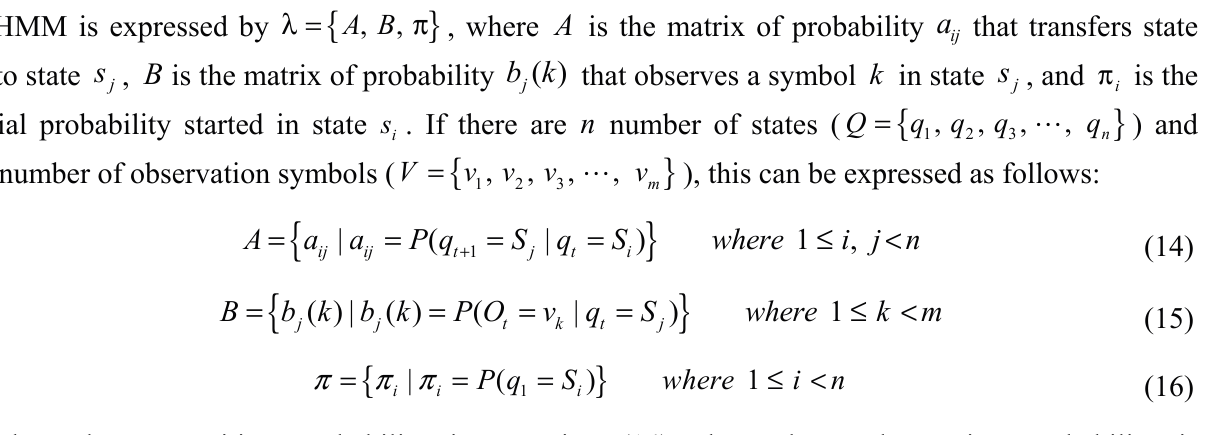
Figure 7. Example of the left-right